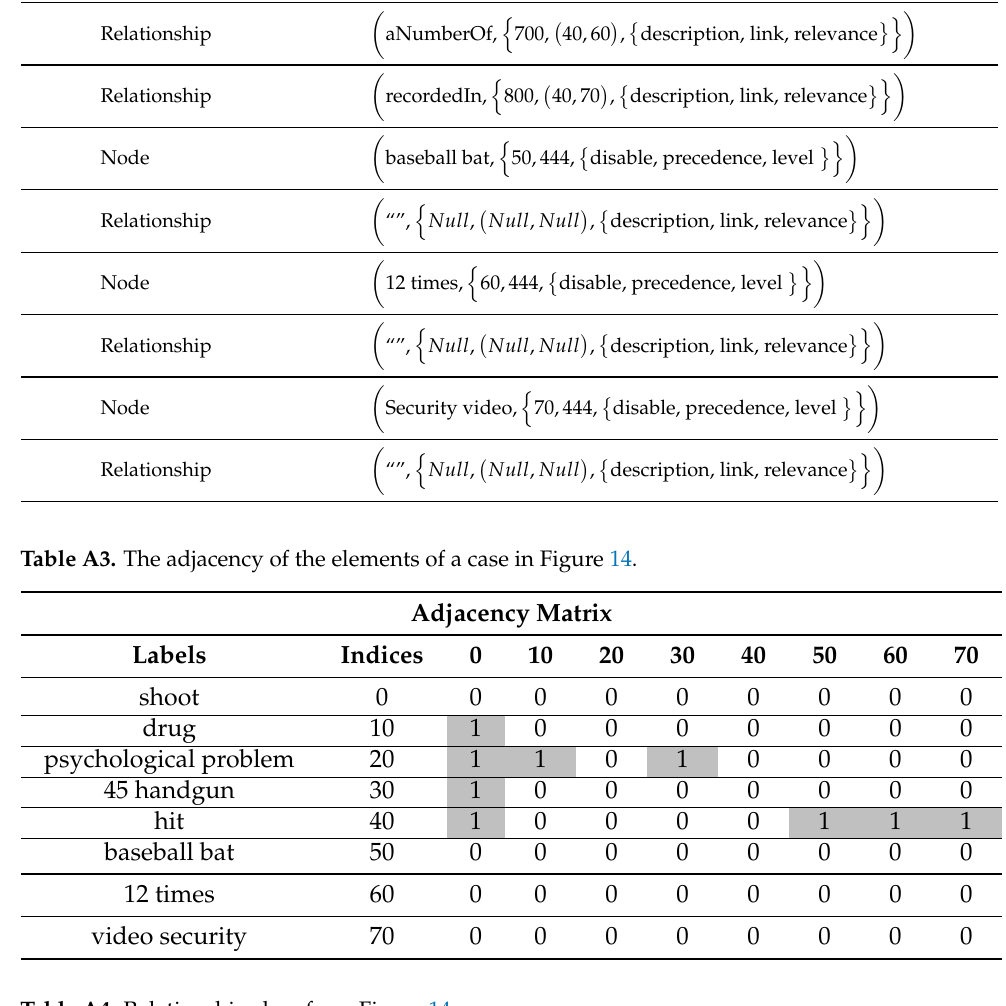
Table A4. Relationships box from Figure